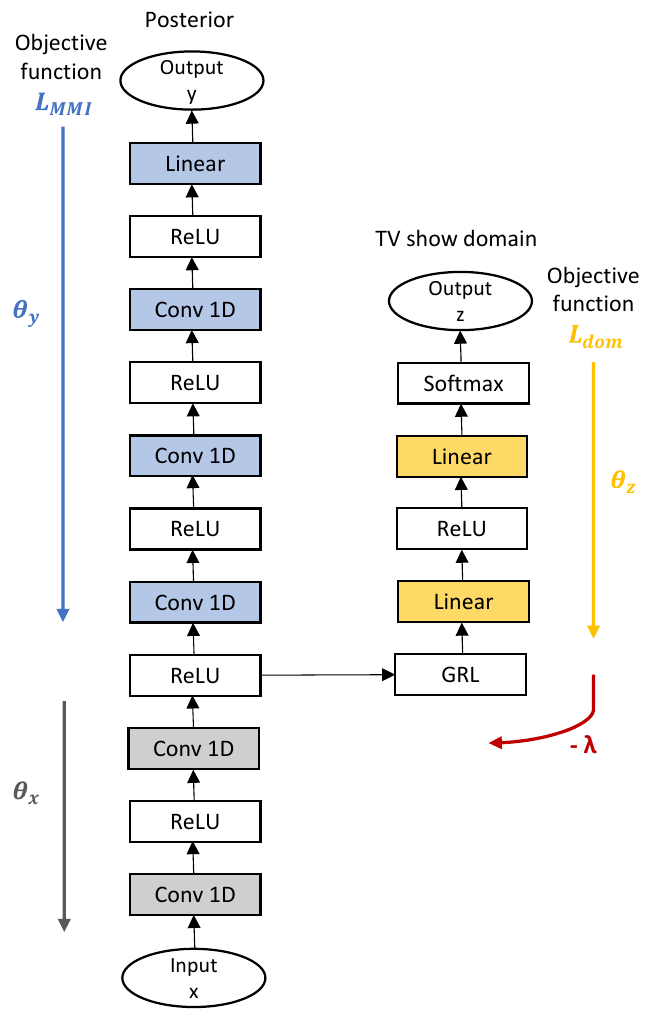
Figure 1. Architecture of the end-to-end LF-MMI approach applying DAT. An adversarial branch (TV show classifier) is added to the second layer of the main PyChain architecture (posterior